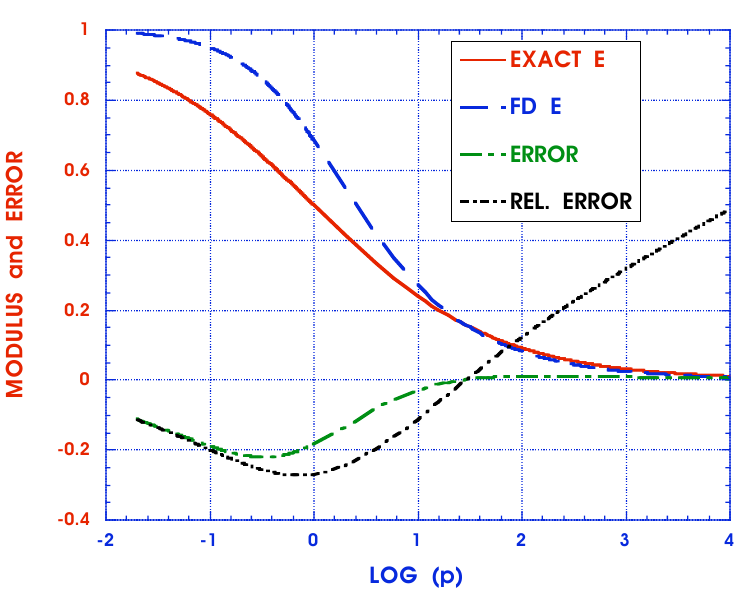
Figure 6. Laplace transform